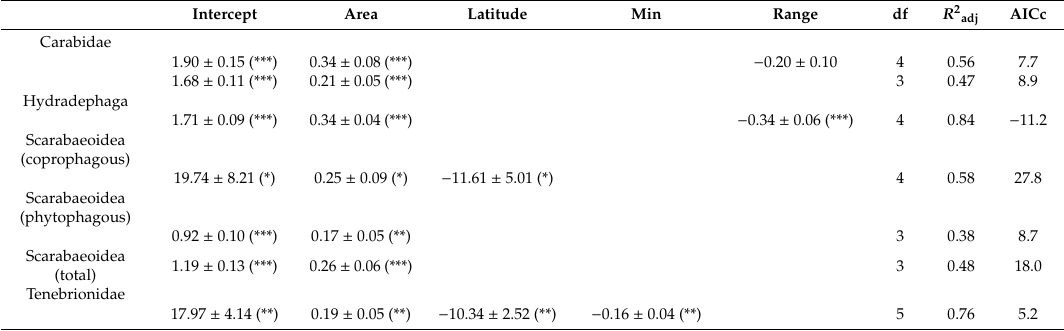
Table 3. Best fit models for the influence of area, latitude, and elevation on beetle richness in Italian reserves. Min: Minimum elevation (m); Range: Elevational range (m); df: degrees of freedom; R 2 adj : adjusted R 2 ; AICc: corrected Akaike Information Criterion. Errors refer to standard errors. * = p < 0.05, ** = p < 0.01, *** p <